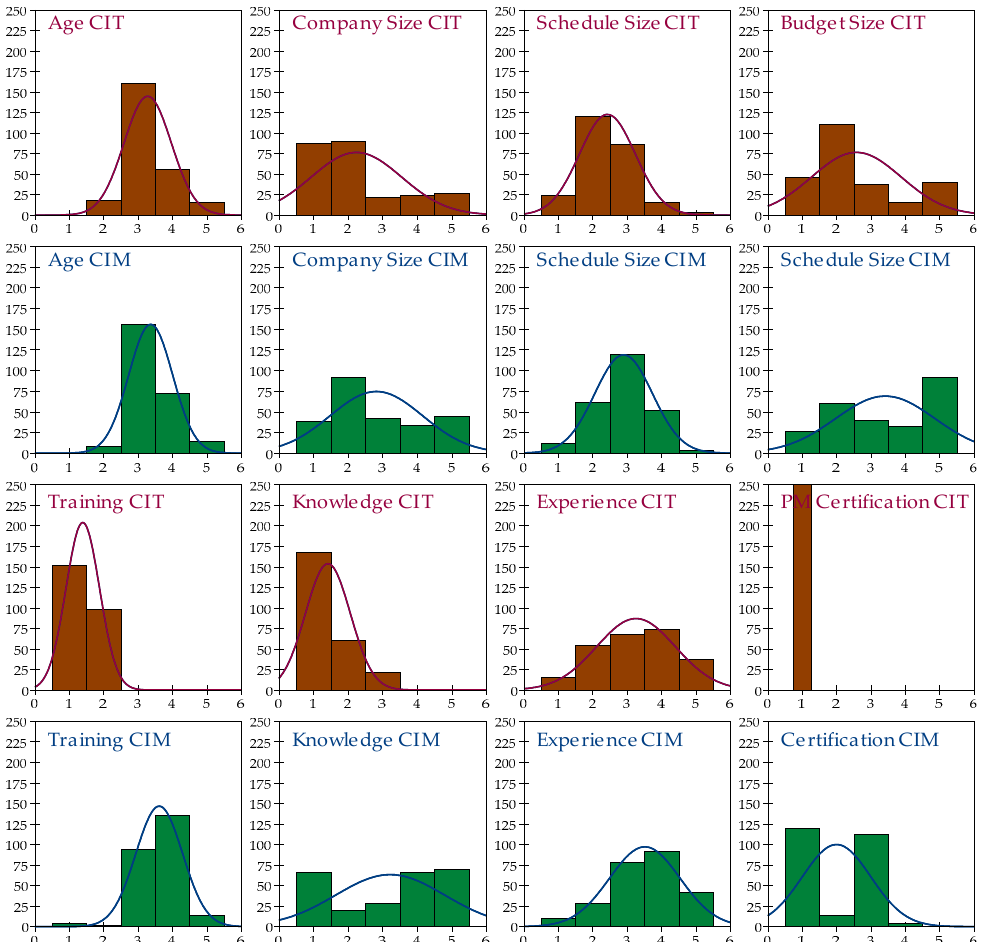
Figure 6. Results of the control questions.